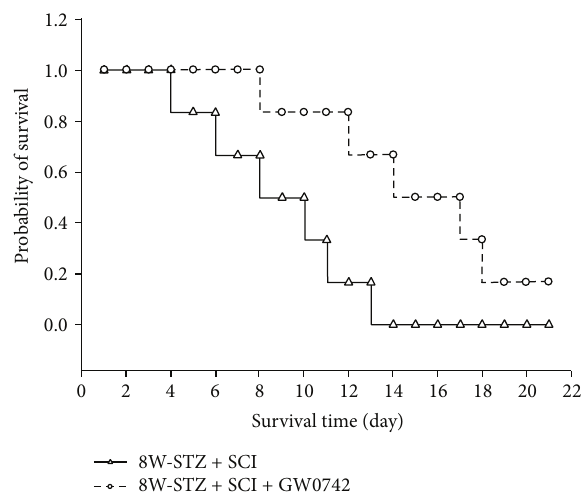
Figure 2: The effect of PPAR 𝛿 activation on survival ability in STZ- diabetic rats after SCI. The eight-week induction group (8W-STZ) was intravenously injected with GW0742 (0.3mg/kg, once daily). Data represent the survival of ten